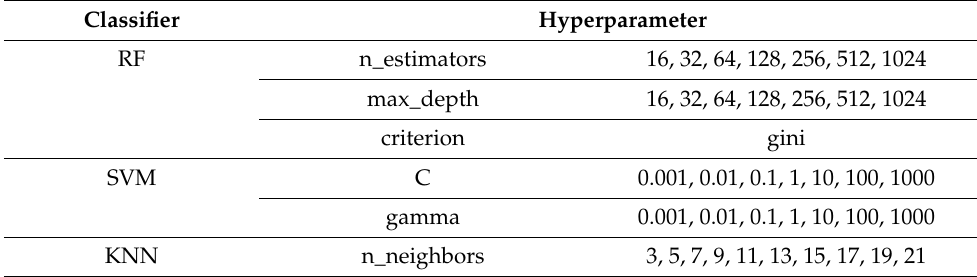
Table 1. Hyperparameters of classifiers for machine